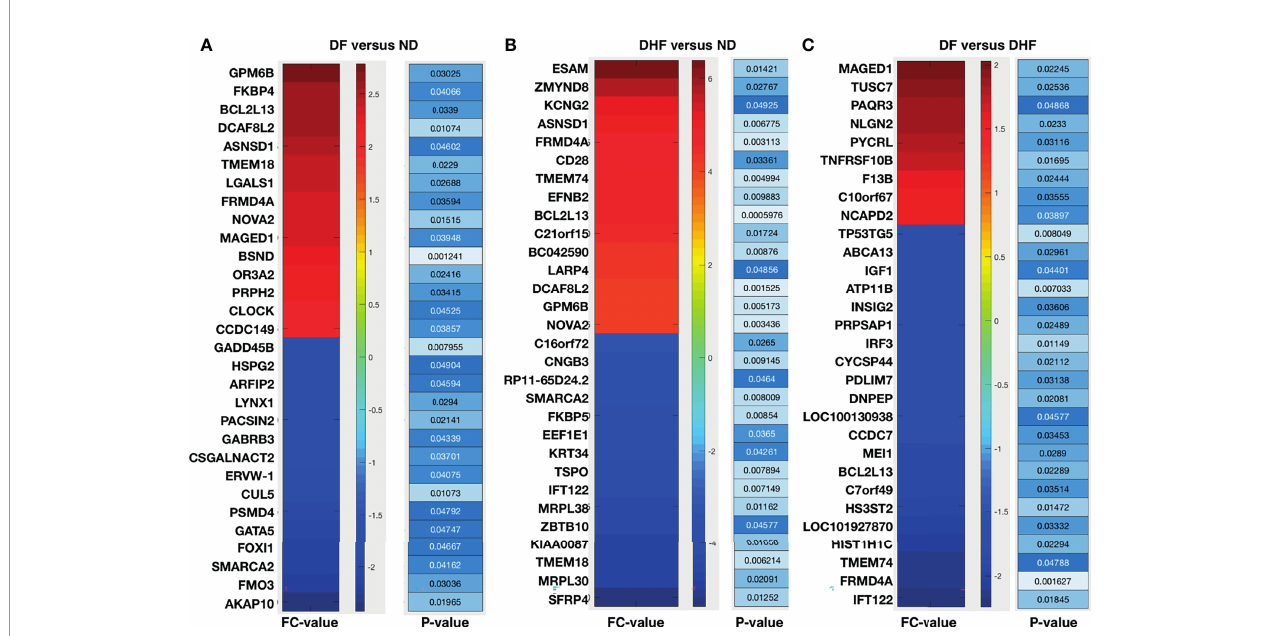
FIGURE 2 | Top 30 DEGs followed by their fold changes and p-values: (A) DF versus ND (B) DHF versus ND, and (C) DF versus